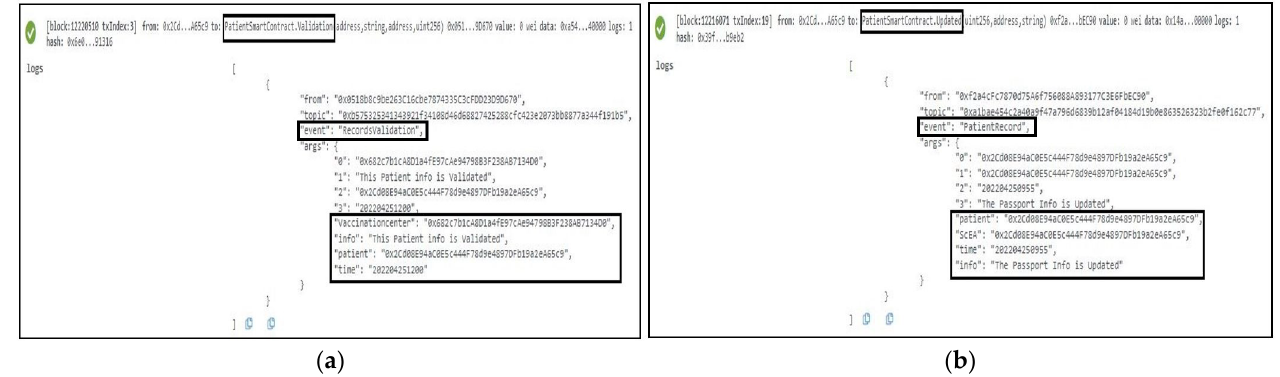
Figure 9. Patient Smart Contract deployed successfully: ( a ) the validation of the patient’s records is confirmed; ( b ) the passport information is updated with patient’s records.